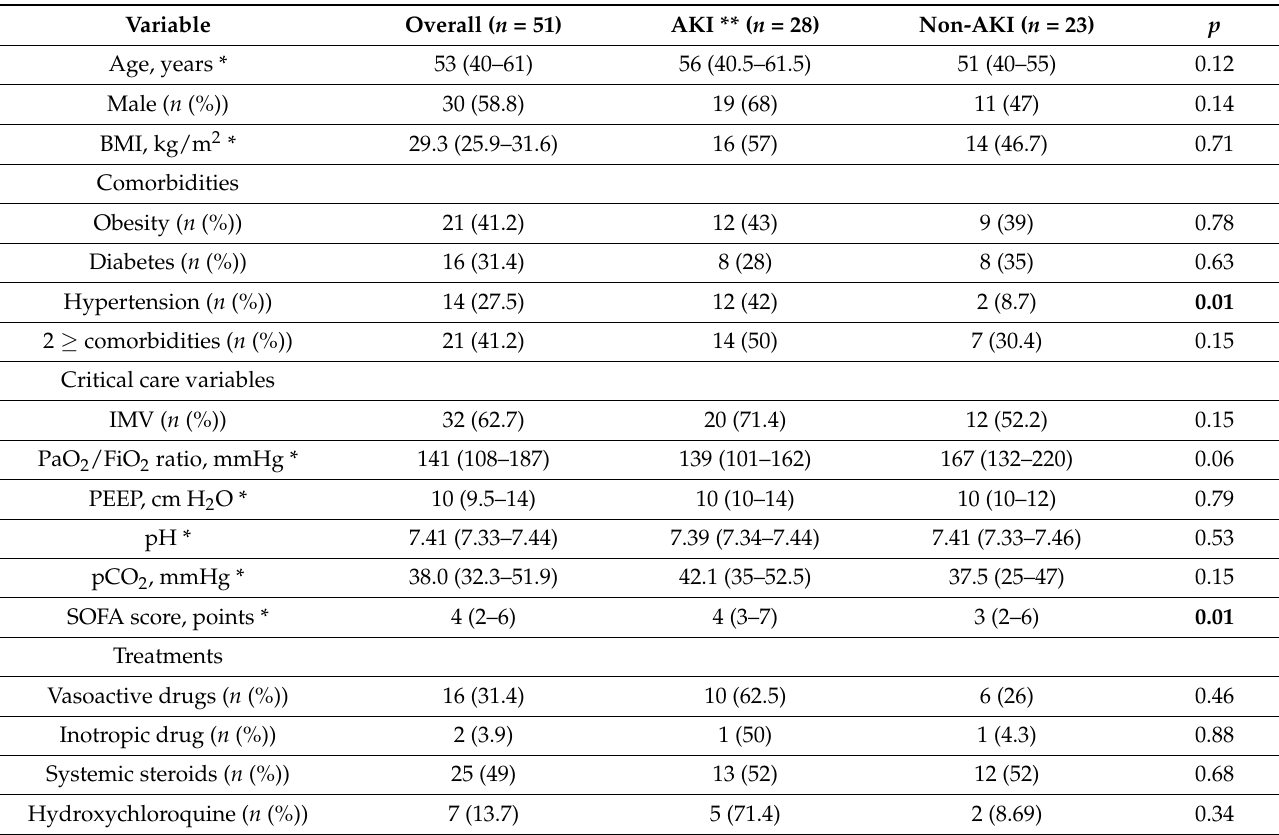
Table 1. Baseline characteristics of the study population.